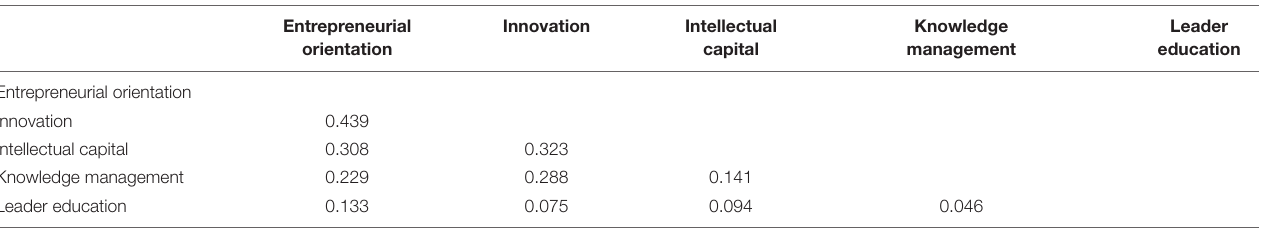
TABLE 4 | Heterotrait-Monotrait Ratio (HTMT) criterion.